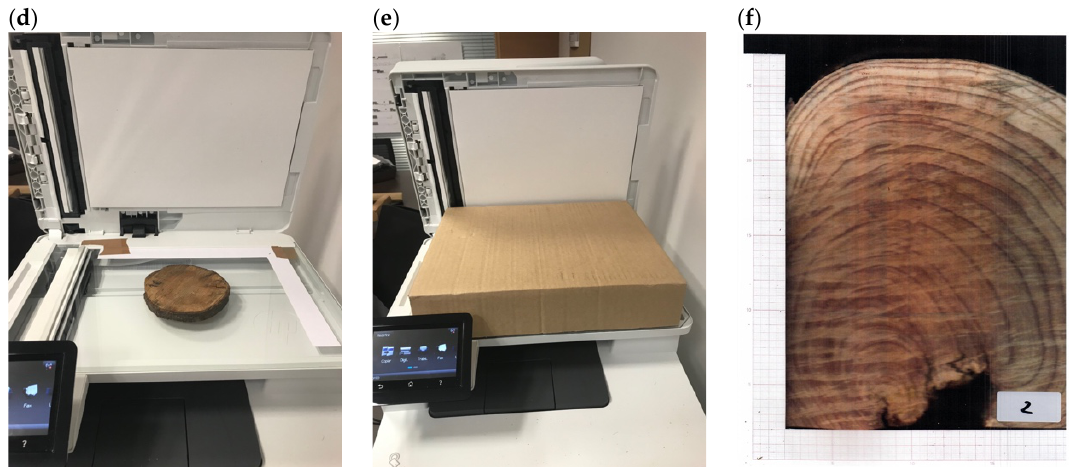
Figure 4. Sequence of the growth ring identification process to determine the age of selected specimens. ( a ) Coarse polishing of the samples, ( b ) fine polishing of the samples, ( c ) final aspect after polishing, ( d ) placing the samples to be digitalized, ( e ) covering the sample to create a dark chamber, and ( f ) digital image of the sample.